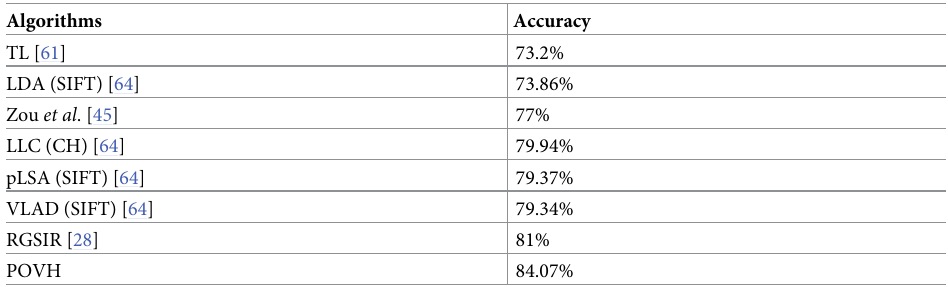
Table 4. Classification accuracy comparison while using RSSCN